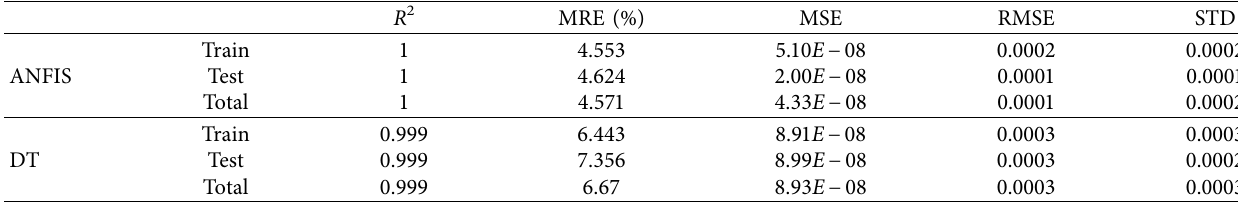
Table 1: Statistical evaluation of DT and ANFIS models.